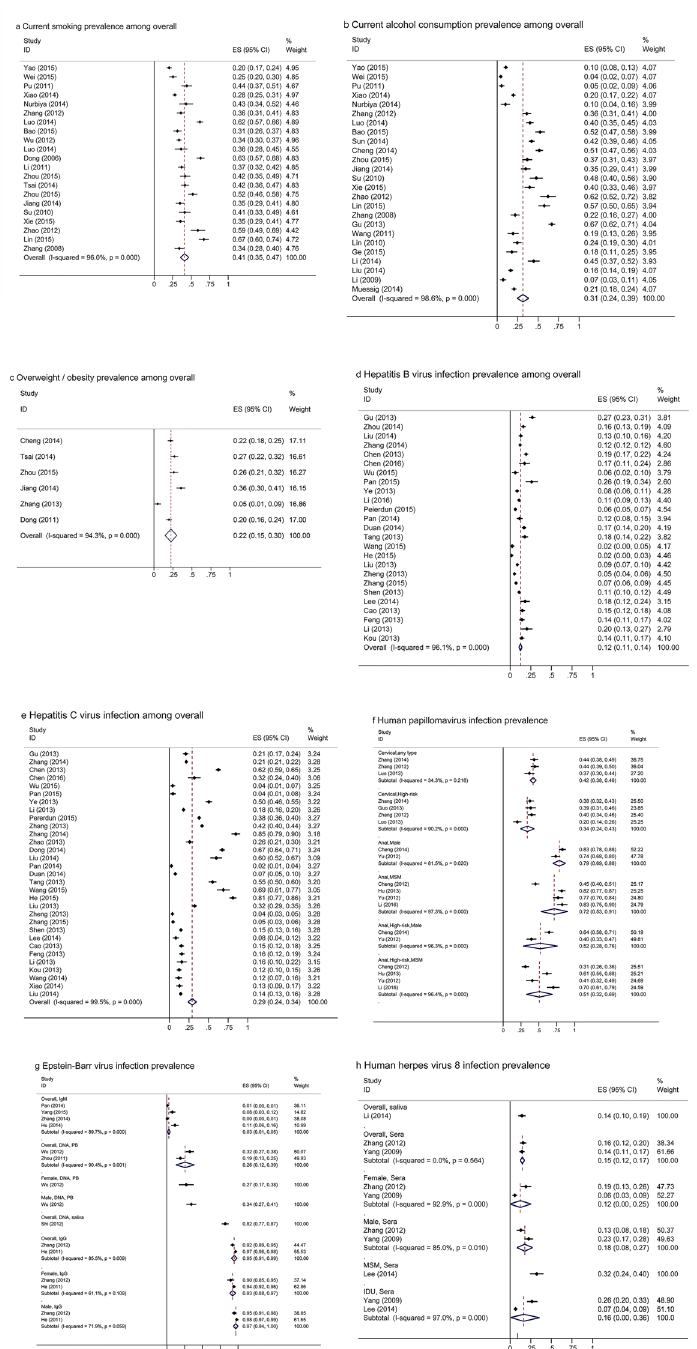
Figure 1. Selected forest plots showing the results of meta-analysis of cancer risk factor prevalence among persons living with HIV/AIDS. ( a ) Current smoking prevalence among overall; ( b ) Current alcohol consumption prevalence among overall; ( c ) Overweight/obesity prevalence among overall; ( d ) Hepatitis B virus infection prevalence among overall; ( e ) Hepatitis C virus infection prevalence among overall; ( f ) Human papillomavirus infection prevalence; ( g ) Epstein-Barr virus infection prevalence; ( h ) Human herpes virus 8 infection